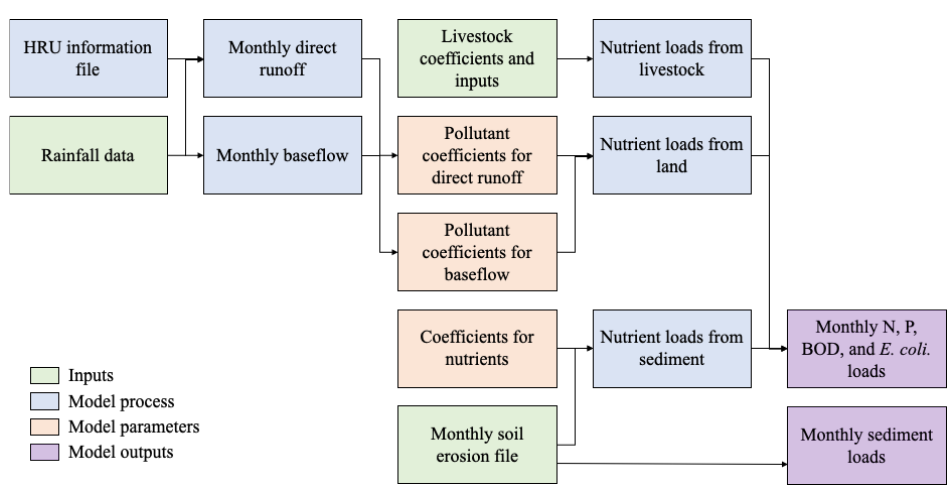
Figure 4. Schematic illustration of streamflow and NPS pollutant load estimation.